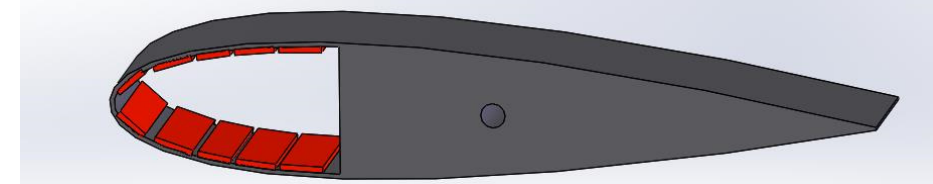
Figure 5. Blade model with the PZT patches.